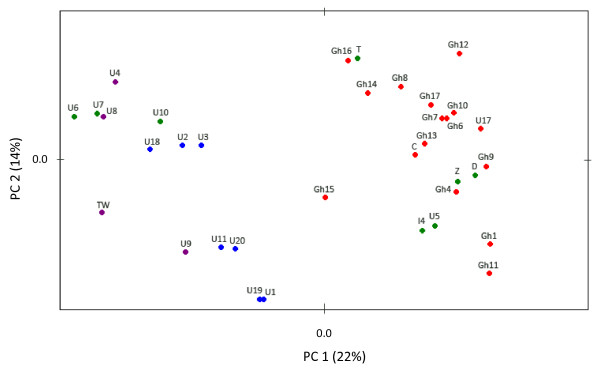
Principal Component Analysis of microsatellite allele frequencies of Monomorium pharaonis colonies. Colour coding is by continent; red: Africa, green: Europe, blue: America, purple: Asia. Colony labels are as in Table 1. The explained variances are given in parentheses.